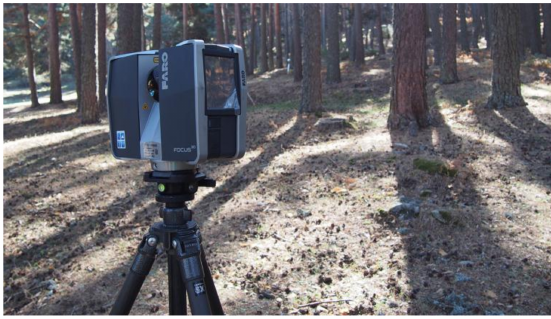
Figure 2. FARO Focus3D TLS device collecting 3D data in a forest